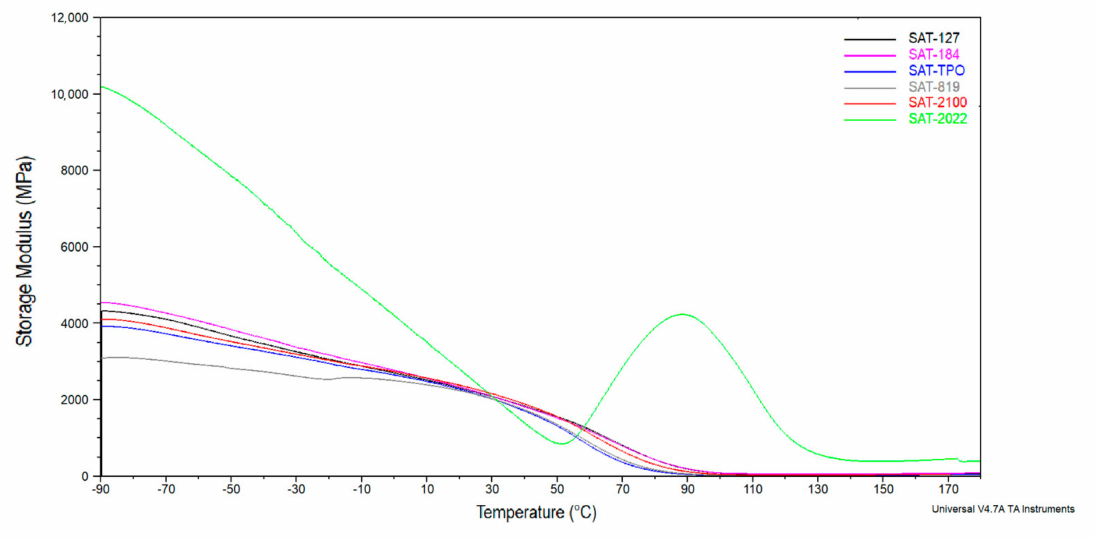
Figure 9. Storage modulus for thermally cured